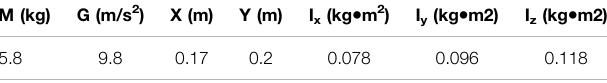
TABLE 1 | Related parameters of AUV.